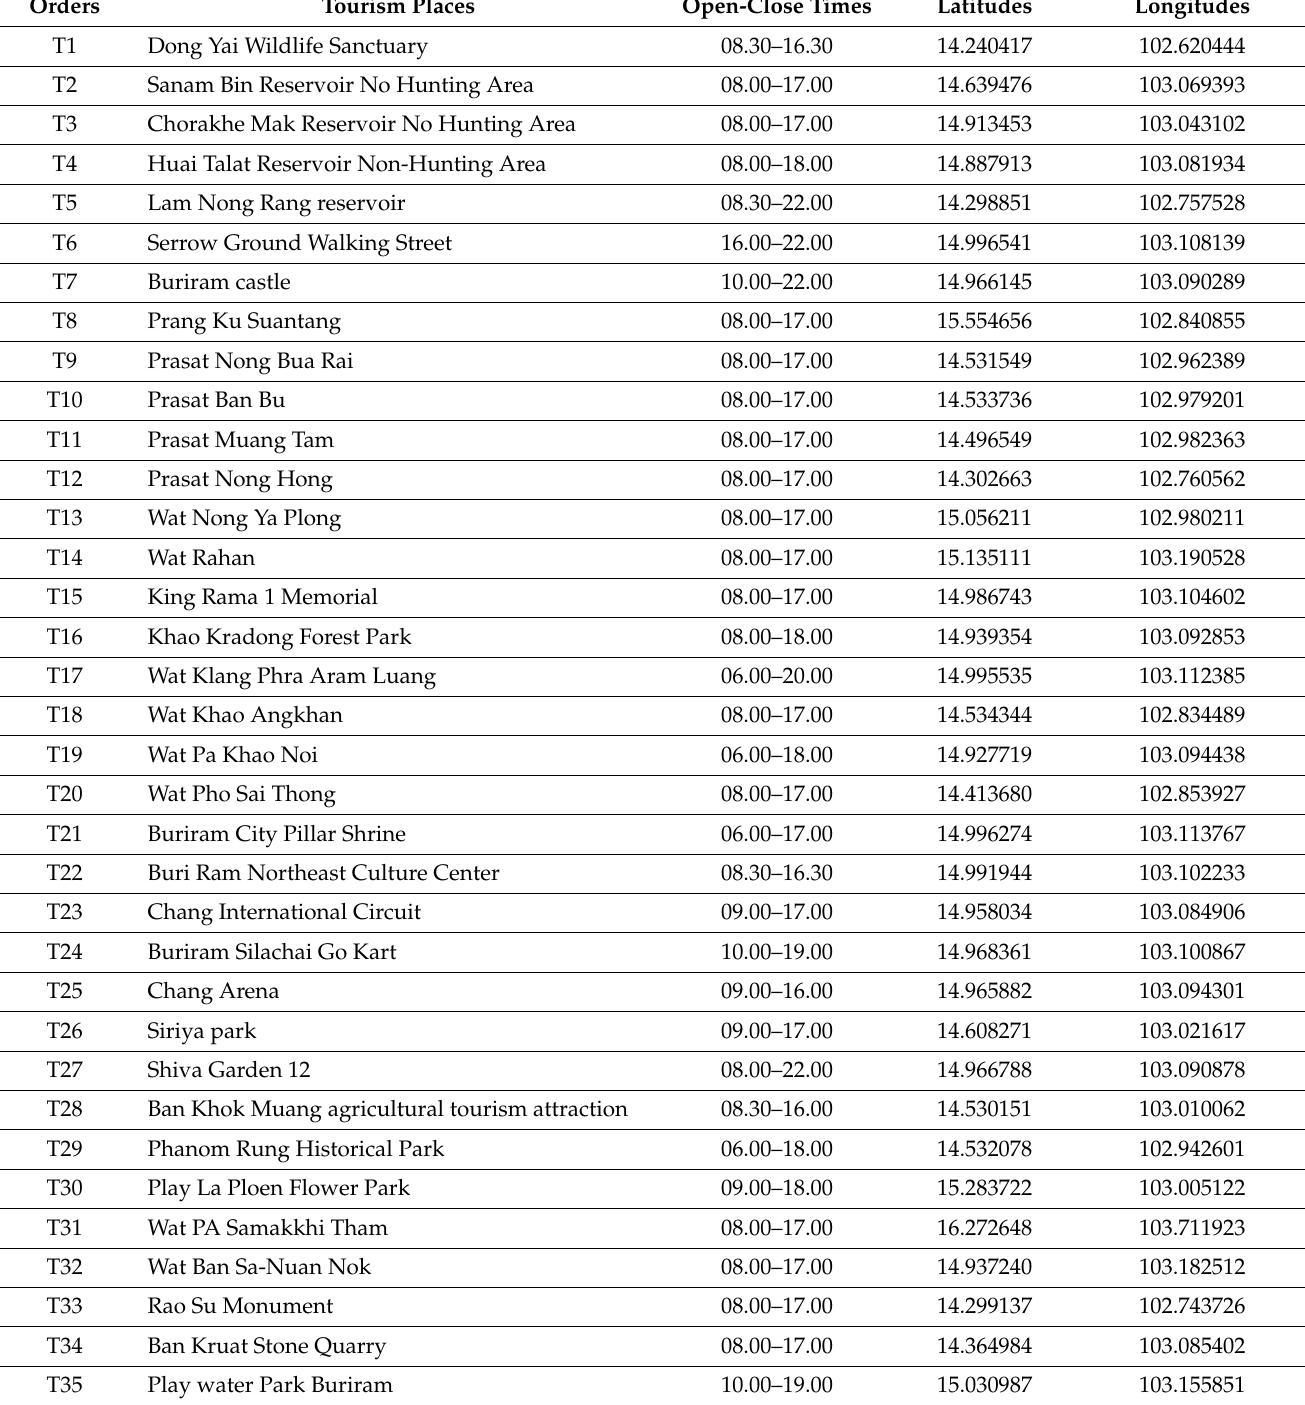
Table A1. Dataset input for testing